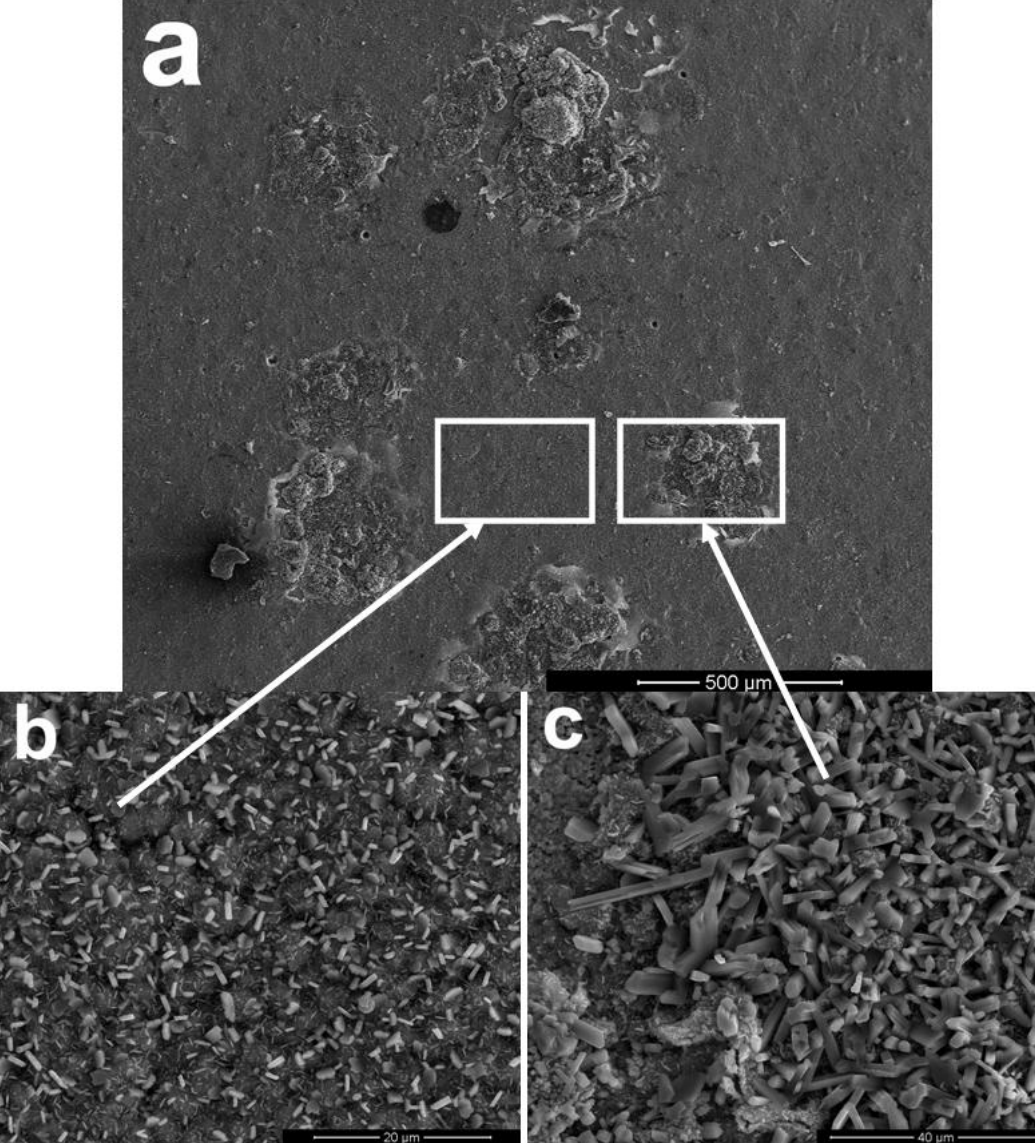
Figure 2. Scale morphology of coating K38-0Y after 60 h exposure at 900  C: ( a ) surface morphology, ( b ) magnified view of surface morphology of alumina scale, ( c ) magnified view of spalled area on the surface, ( d , e ) are the cross-sectional morphologies corresponding to ( b , c